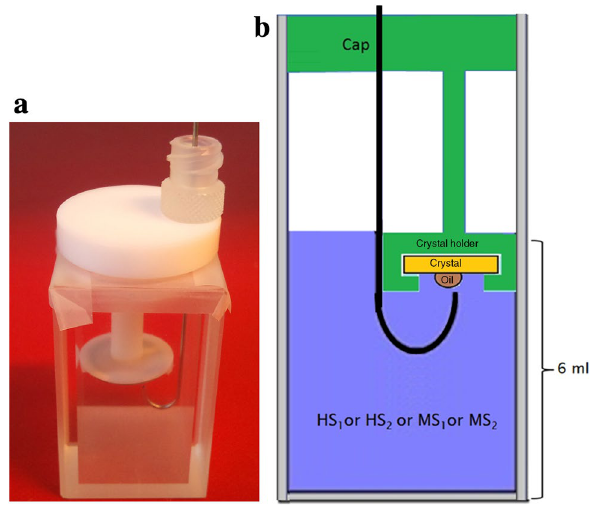
Fig. 1 a Left picture: The glass chamber and its custom-made crys- tal holder. b Right picture: The schematic of placing oil drop on the surface of silica crystal by hooked